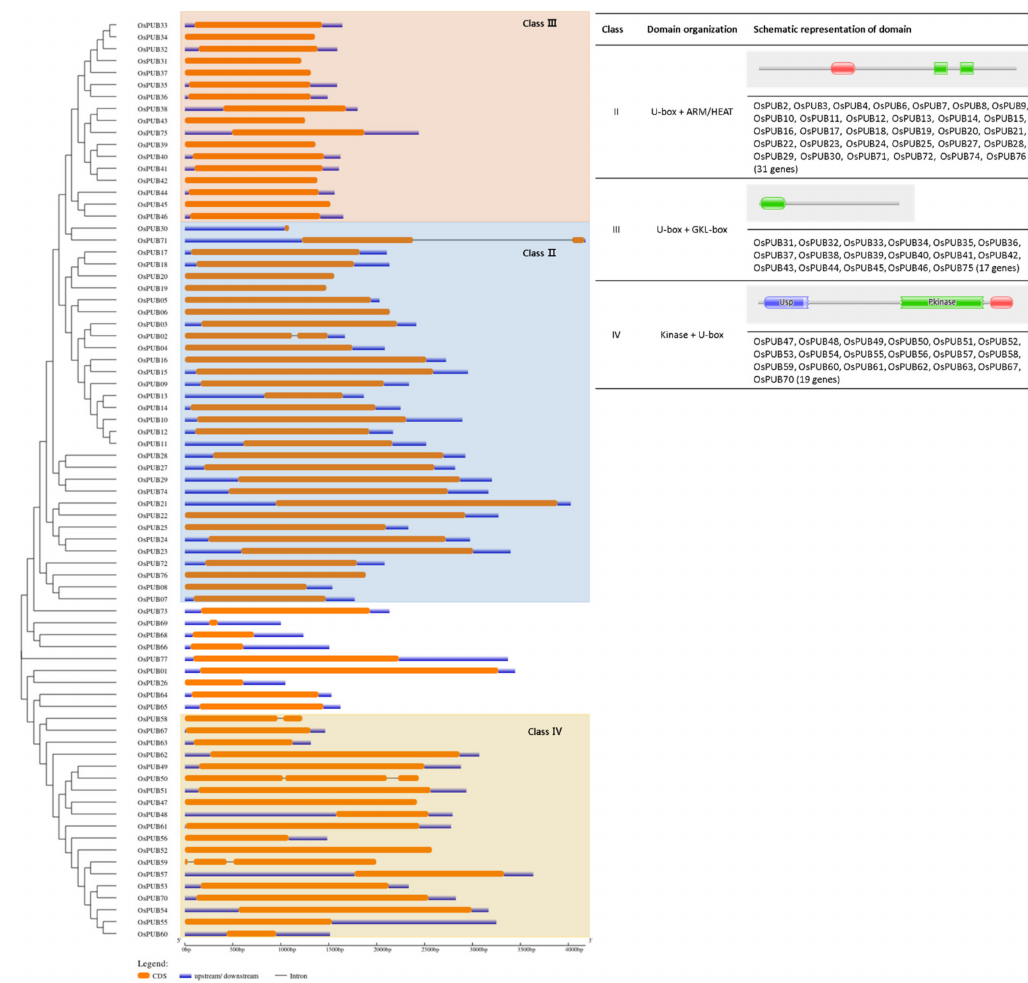
Figure 3. Exon/intron distribution of 77 rice U-box gene family members was analyzed with the GSDS tool. Coding sequences were compared with their corresponding genomic sequences. The orange box represents the CDS. The continuous black line represents the intron region. Blue boxes represent upstream/downstream